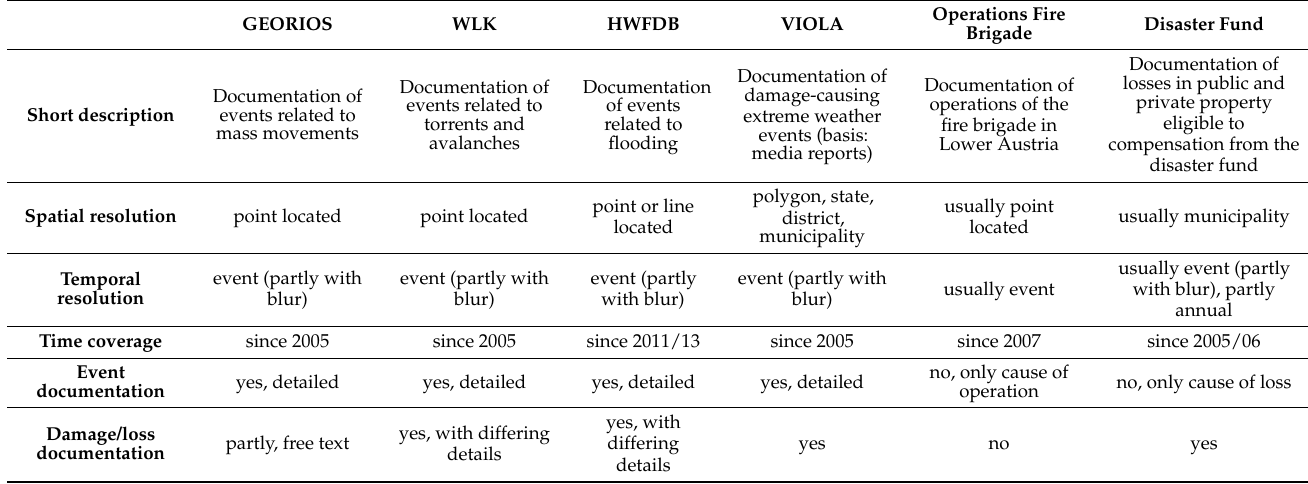
Table 1. Overview of the available